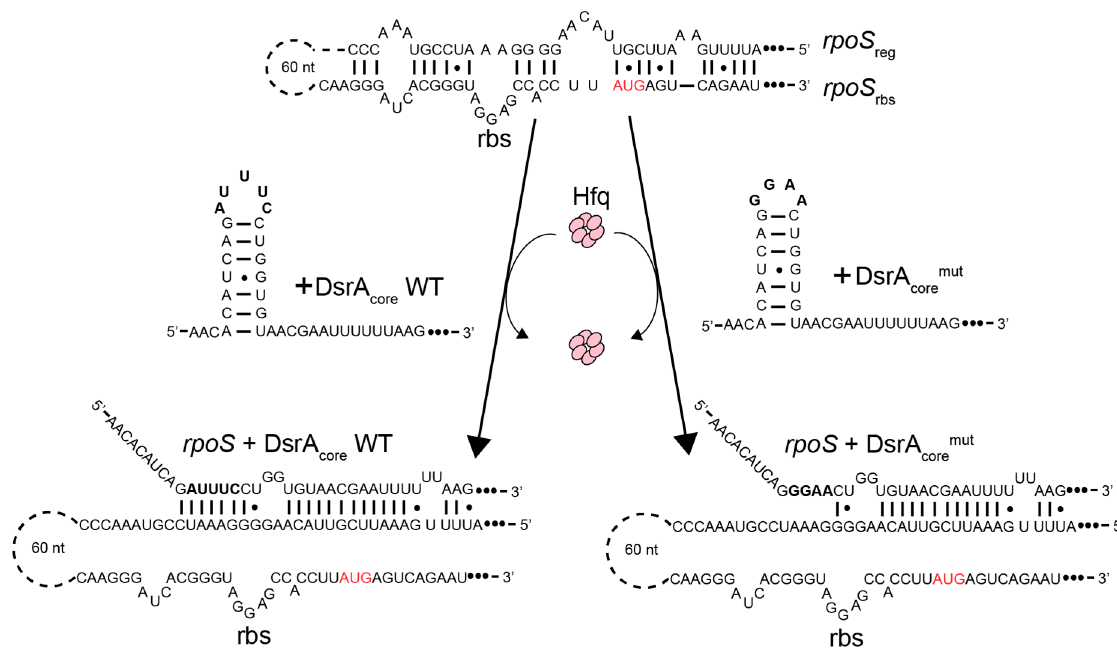
Figure 1. DsrA and rpoS fragments used in SRCD experiments. Base pairing of DsrA with the leader sequence of rpoS enhances its translation by exposing the ribosome binding site ( rbs ) and start codon (AUG), which are sequestered in the inhibitory stem structure. This process requires the RNA chaperone Hfq. Until now, Hfq-CTR was described as dispensable for this activity.